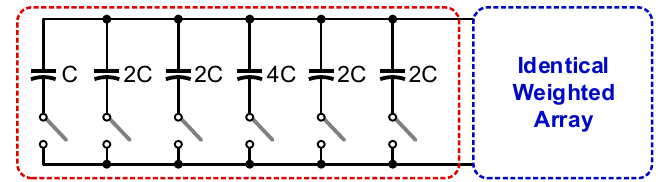
Figure 11. CDAC configuration for higher resolution.